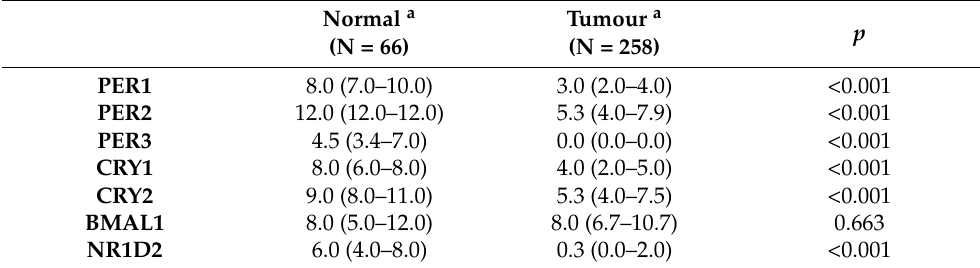
Table 3. Expression of circadian clock-related proteins in normal and tumour colorectal samples.